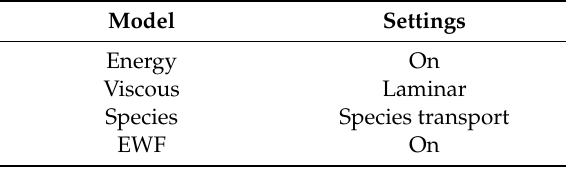
Table 1. Models used. EWF: Eulerian wall film.